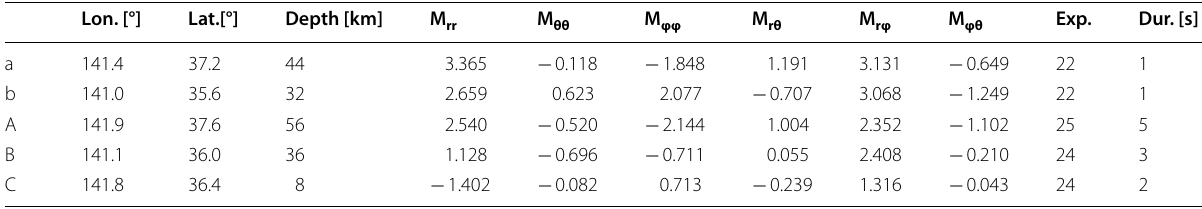
Origin times of events a, b, A, B, and C were 10:02:45 JST on November 17, 2017, 19:56:05 JST on August 6, 2018, 19:23:01 JST on August 4, 2019, 03:23:54 JST on January 3, 2020, and 20:19:56 JST on February 6, 2020, respectively. Source durations were assumed using the empirical relationship between seismic moments and durations (Kanamori and Brodsky 2004)